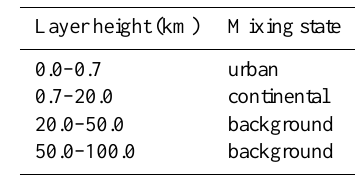
Figure 9. The mean MACC-II NO 2 profile forecast over Leicester at 12:00(GMT) on 28 February 2013. The boundary layer profiles assumed in this work are shown in Fig. 17. Table 3. The aerosol loading scenario based on the WMO climatol- ogy assumed for all ground pixels in this